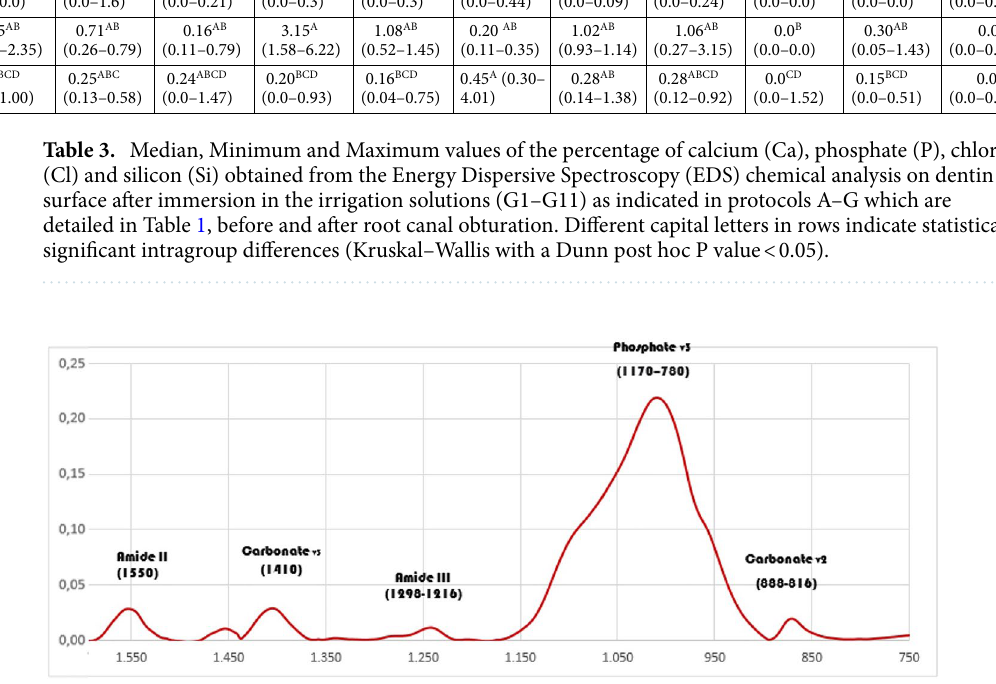
Figure 2. Representative infrared spectral region between 1600 and 750 cm −1 of untreated dentin showing the absorption peaks of the main dentin